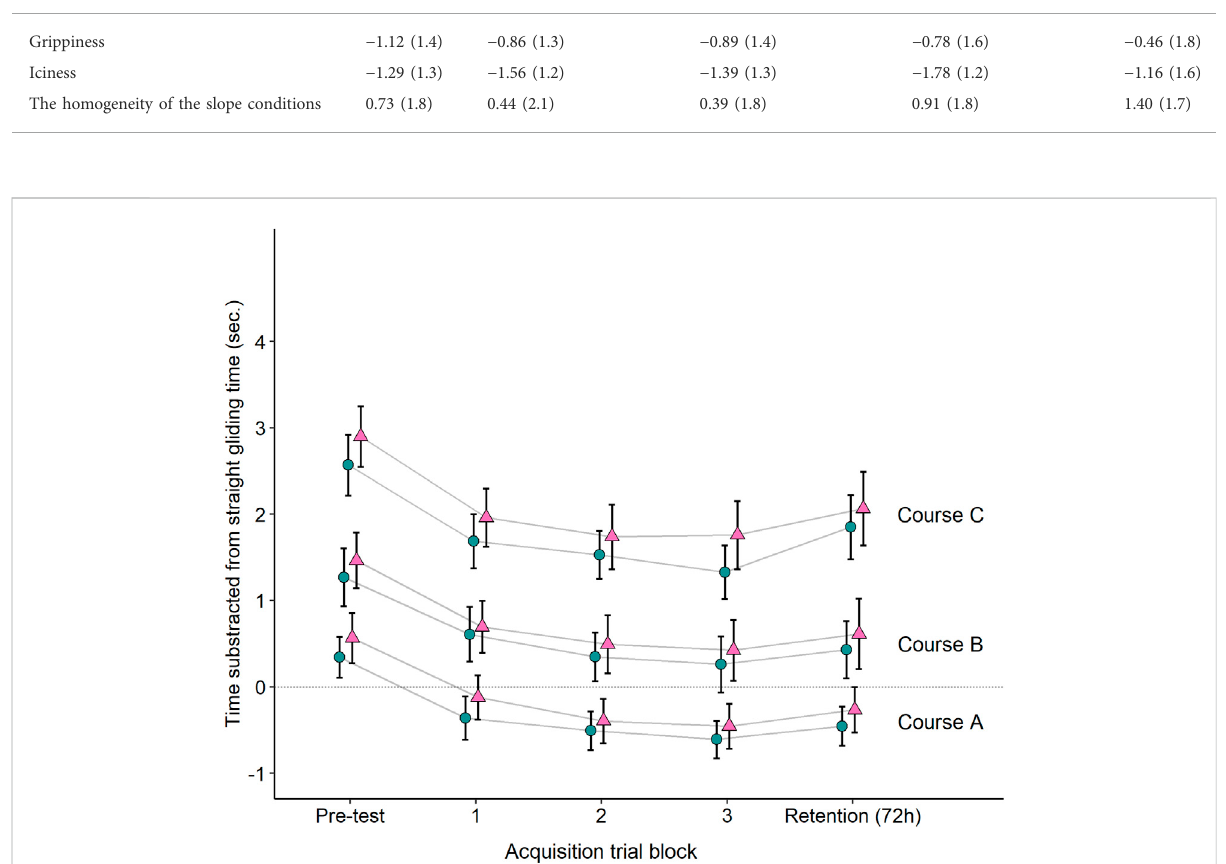
FIGURE 3 Sample means and 95% con fi dence intervals for the blocked (red triangle) and the interleaved (blue circle) in courses A, B and C. Performance wascomputedbycalculatingtheaveragetimetheparticipantachievedforeachcourseandsubtractingitfromthemeanofhisorherstraight-gliding time on that day. A lower score, therefore, indicates a better performance. The dashed black line depicts when the performance was equal to the straight-gliding performance. To analyze the acquisition, the runs were numbered in the three courses from 1 to 12. We then placed 1 – 4 into Acquisition trial block 1, 5 – 8 into Acquisition trial block 2 and 9 – 12 into Acquisition trial block 3. Please note that not all skiers completed all the training